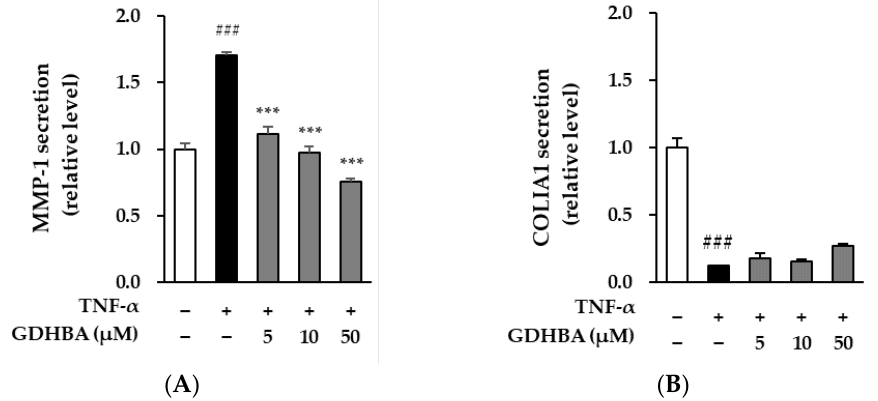
Figure 3. Effect of GDHBA on MMP-1 ( A ) and COLIA1 ( B ) secretion in TNF- α stimulated HDFs. HDFs were pretreated with 5, 10, and 50 μM of GDHBA. ( A , B ) for 1 h and then incubated for 24 h with TNF- α (20 ng/mL). MMP-1 and COLIA1 secretion was quantified using an ELISA kit. Each bar represents mean ± SEM. ### p < 0.001 versus normal control. *** p < 0.001 versus stimulus alone. Int. J. Mol. Sci. 2022 , 23 , 14802